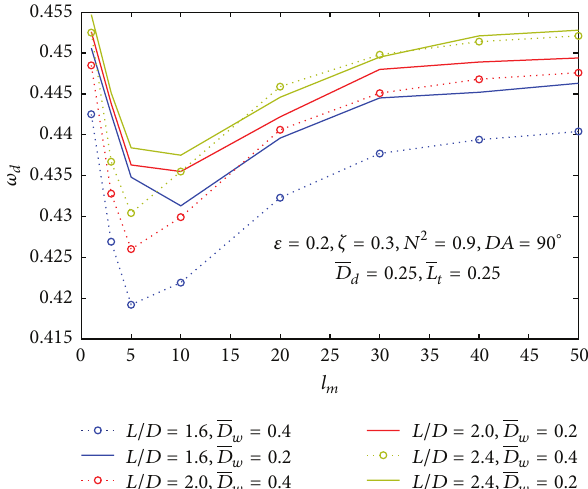
Figure 13: Variation of damped frequency of whirl 𝜔 𝑑 as a function of characteristics length “ l m